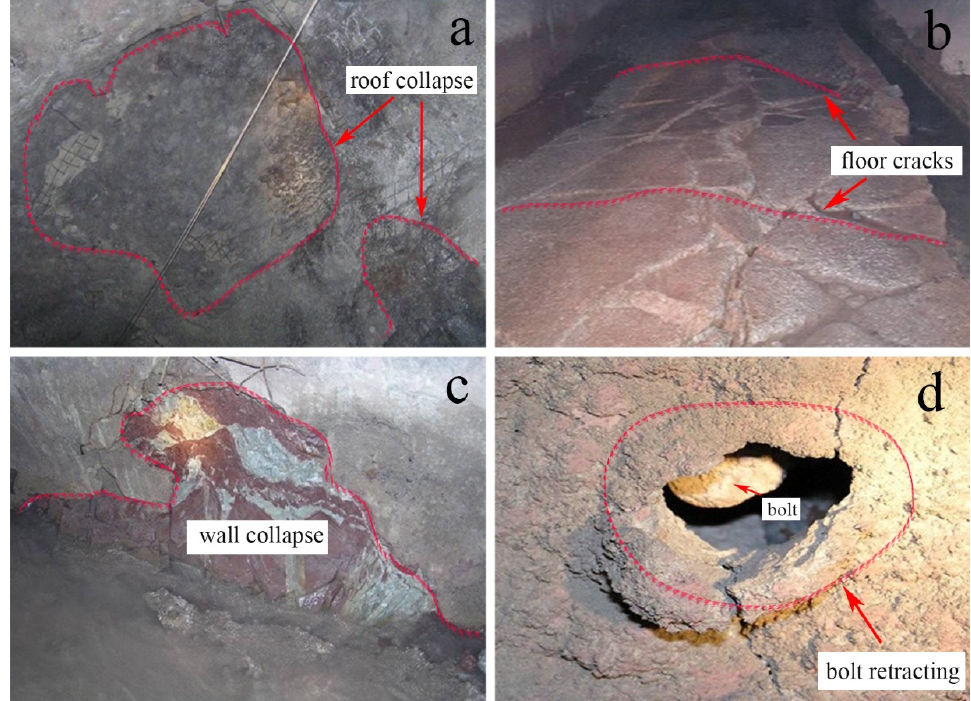
Figure 11. The different roadways failure phenomenon in Kaiyang Phosphate Mine area. Note: ( a ) roof collapse; ( b ) floor cracks; ( c ) wall collapse; ( d ) bolt retracting.